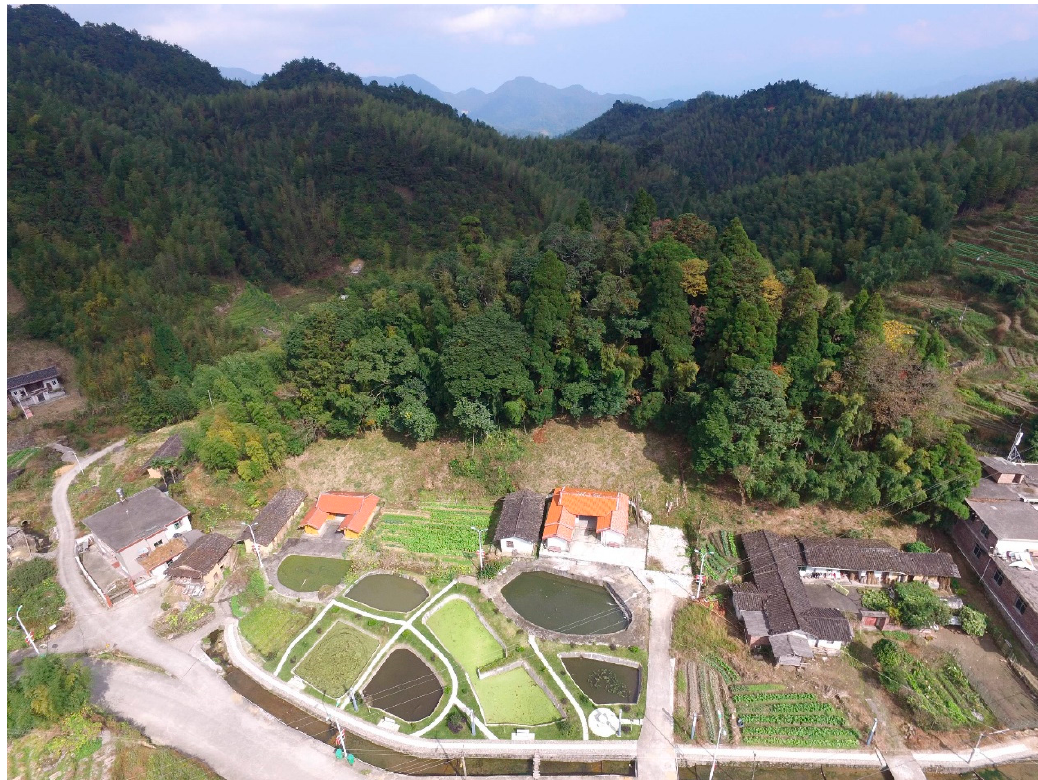
Figure 7. The main ancestral temple ( citang ) of Gonghe Village with a small, crescent-shaped houlongshan (back dragon mountain)-type forest protecting it. The ponds in front of the ancestral temple represent the seven stars of the big dipper. A classic fengshui feature, these pools hold heat in the winter and cool the area in the summer. (Drone photo by the author, 2018).